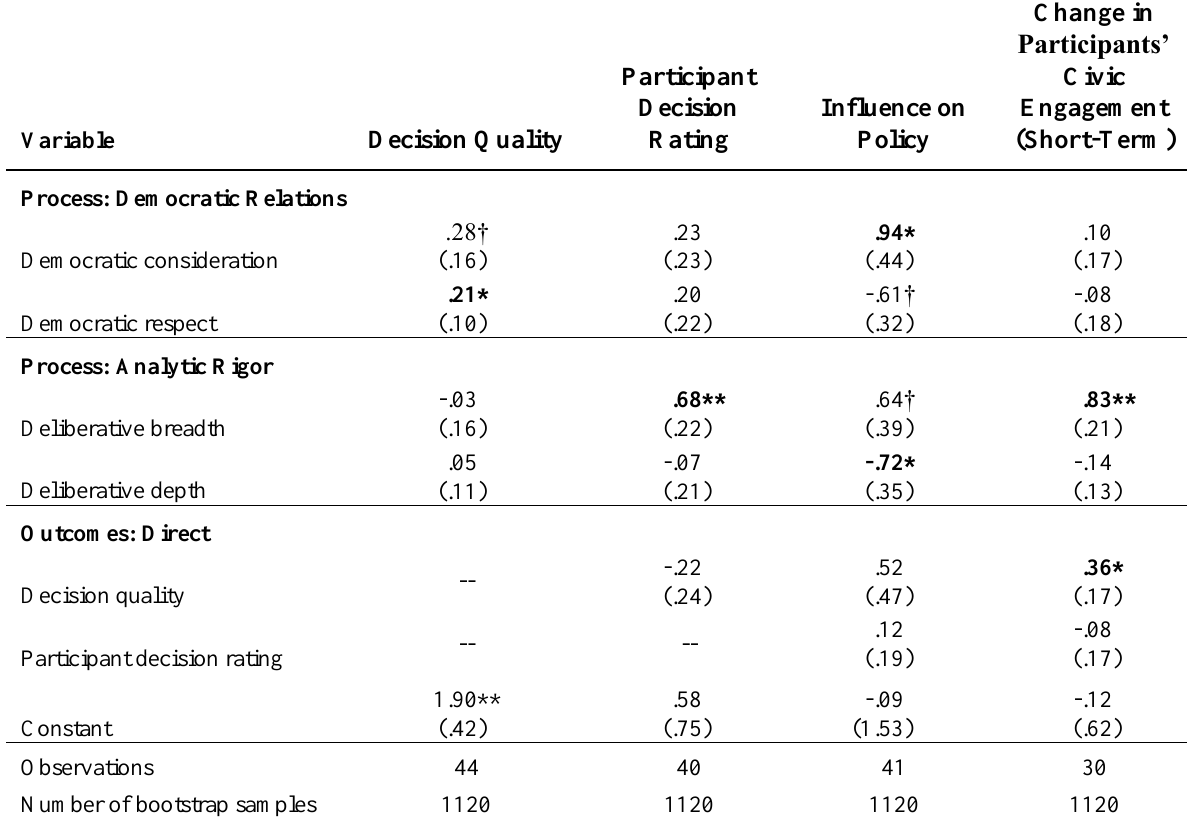
Bootstrap Regression Models of Outcome Measures in Participedia